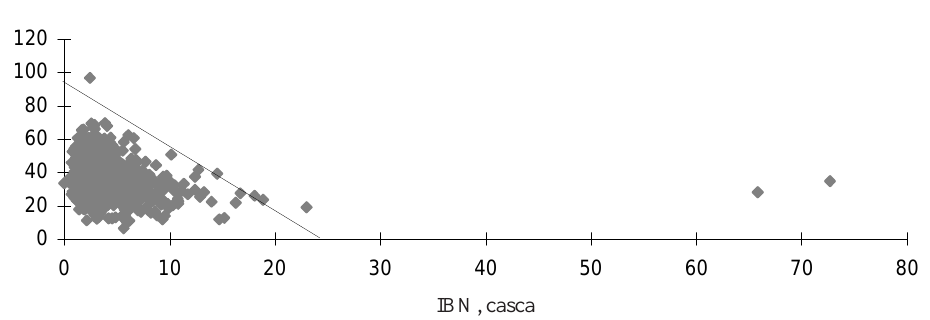
Figura 3. Gráfico de dispersão para o incremento médio anual do lenho (IMA) em relação ao índice de balanço nutricional (IBN) da casca de 1.213 árvores adultas de